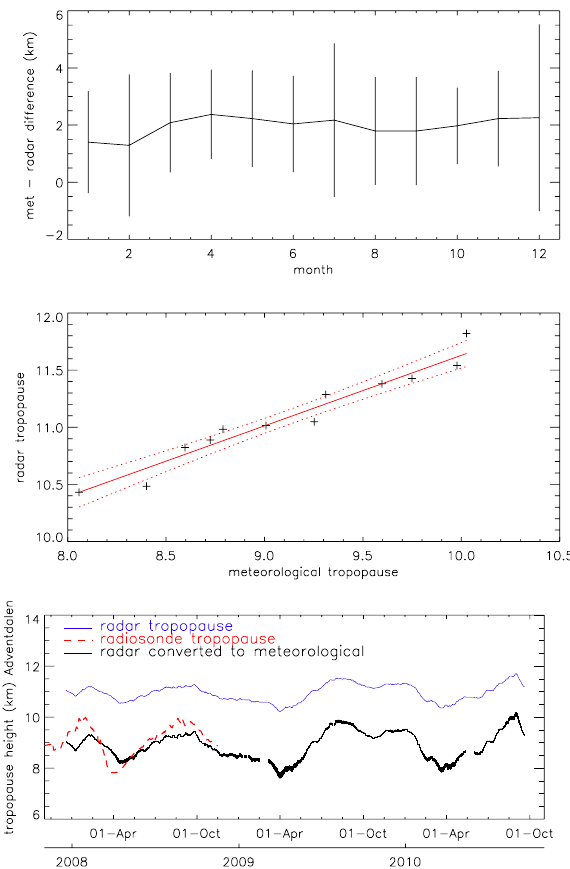
Fig. 3. Upper panel: the height difference between radar and ra- diosonde tropopause determinations. Although showing a distinct seasonal variation, the peak to peak magnitude is only 1km. Verti- cal bars indicate standard deviations corresponding to the monthly means. Middle panel: linear regression of radar tropopause on me- teorological tropopause heights (+) together with 95% confidence limits (dotted hyperbolae). Bottom panel: tropopause determina- tions for the period of observation with 30-day Lee filter applied for clarity. Thin upper line: radar determination; lower dashed line: radiosonde determination; solid thick line: estimate the meteoro- logical tropopause (uncertainties based on those of the regression indicated by line